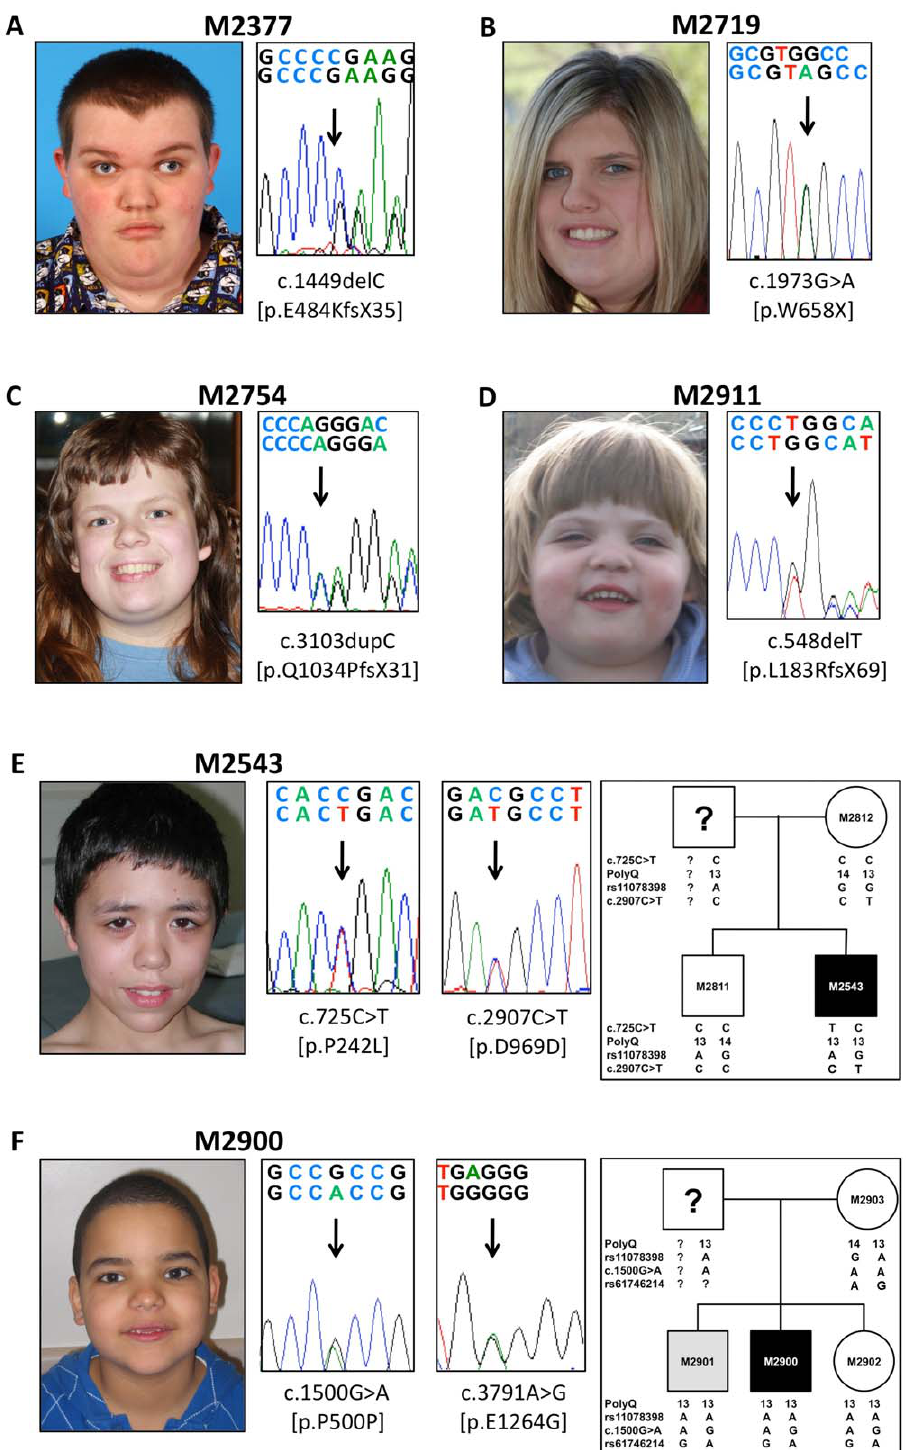
Figure 2. SMS patients and their identified RAI1 variants. (A) Patient M2377 (pictured at age 20 years) carried the de novo frameshift variant c.1449delC. (B) Patient M2719 (pictured at age 17 years) carried the de novo nonsense variant c.1973G . A. (C) Patient M2754 (pictured at age 18 years) carried the de novo frameshift variant c.3103insC. (D) Patient M2911 (pictured at age 5 years) carried the de novo frameshift variant c.548delT. (E) Patient M2543 (pictured at age 14 years) was heterozygous for the c.725C . T and c.2907C . T variants. The pedigree of his family contains the genotypes of his mother (M2812) and his unaffected brother (M2811) for the identified variants as well as the informative SNP rs11078398 and the polyQ repeat sequence. His father’s genotype could be partially reconstructed; no paternal DNA was available for sequencing. (F) Patient M2900 (pictured at age 6 years) was heterozygous for the c.1500G . A and c.3791A . G (rs61746214) variants, which were also present in his brother with developmental delay (M2901) and in his unaffected sister (M2902). His family pedigree shows these variants as well as the informative SNP rs11078398 and the polyQ repeat sequence. His father’s genotype could be partially reconstructed (no DNA was available).